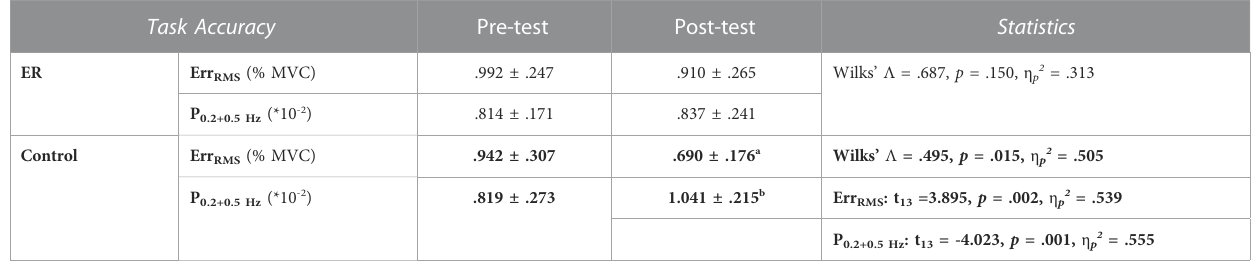
TABLE 1 Means and standard errors of task accuracies in the time/spectral domains in the pre-test and post-test for the ER and control groups. (Err RMS : root mean square of the task error; P 0.2+0.5Hz : combined amplitudes of 0.2 Hz and 0.5 Hz spectral peaks in the force output).